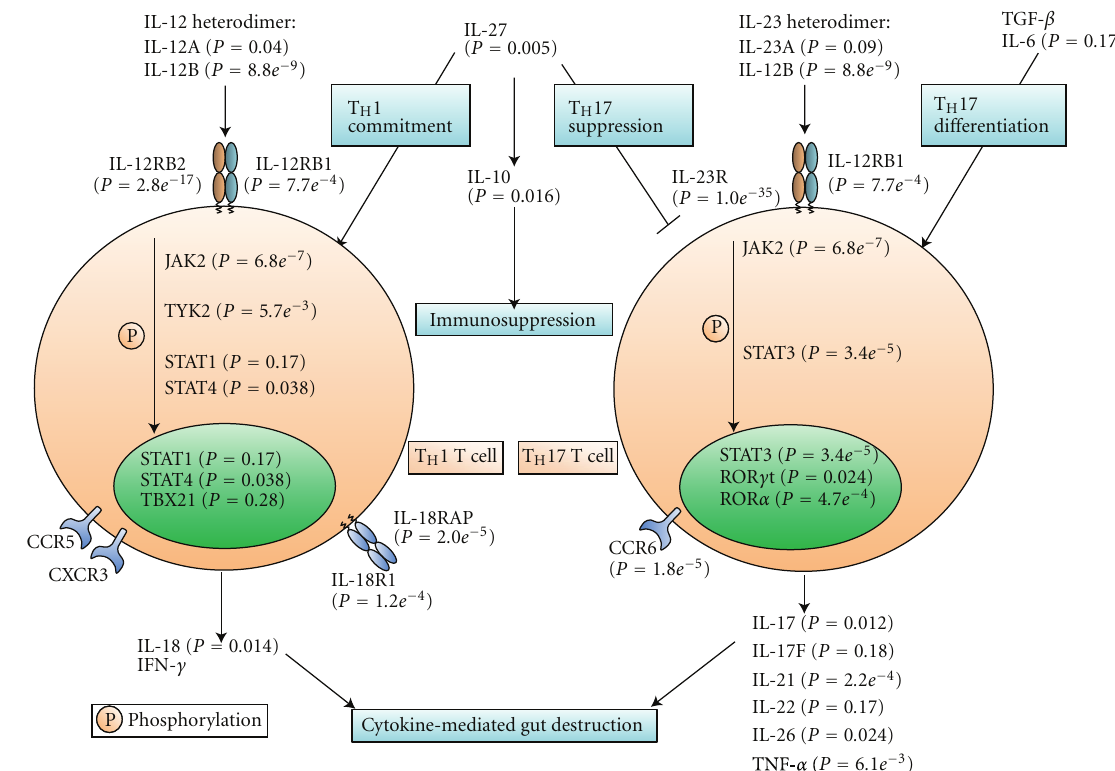
Figure 2: Linking pathways to disease: Crohn’s disease (from Wang et al. [5]). As an example of how biological pathways are involved in disease pathogenesis, the authors illustrate a manually compiled pathway centered on IL-12 and IL-23. For each gene, the most significant P value among SNPs close to the gene (based on GWAS) was annotated. Only three genes at two loci ( IL12B at 5q33 and IL23R - IL12RB2 at 1p31) showed genome-wide significant signals, but three further genes ( JAK2 , CCR6 , and STAT3 ) in the pathway were confirmed as suscep- tibility candidates in replication studies. Six further genes in this pathway were reported as Crohn’s disease susceptibility genes by other asso- ciation and functional